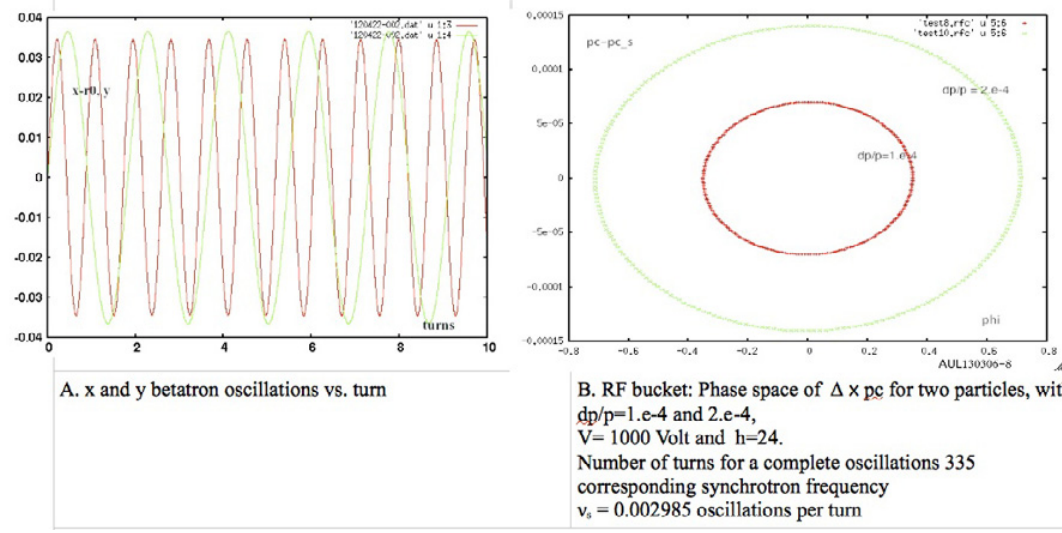
Figure 4. A. betatron oscillations, B. RF